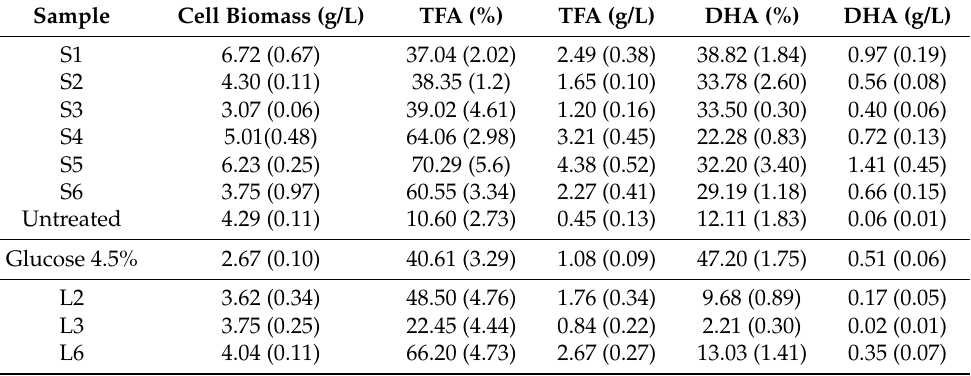
Table 4. Cell biomass growth and accumulation of total fatty acid (TFA) by C. cohnii cell biomass. The carbon source used was hydrolysates from both solid and liquid fraction of organosolv process at wheat straw biomass. Standard errors are given in parenthesis. % TFA represents g of lipids per 100 g of cell biomass, while % DHA refers to the weight percentagewise concentration of DHA in the C. cohnii oil extracted. Pure glucose (4.5 wt%) was also used as a carbon source for comparison.